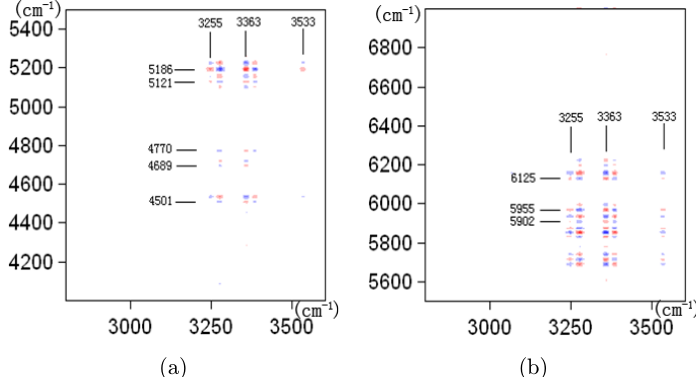
Fig. 5. 2D synchronous correlation spectra of cefuroxime sodium for injection. (a) Spectrum between the IR region of 3800 – 2800 cm (cid:1) 1 and the NIR region of 4000 – 5500 cm (cid:1) 1 . (b) Spectrum between the IR region of 3800 – 2800 cm (cid:1) 1 and the NIR region of 5500 – 7000 cm (cid:1) 1